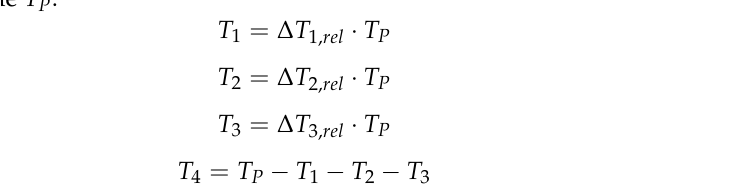
Figure 9. Sinusoidal trajectory for the four strokes with the parameters x peak = 0.03 m and ω = 80 rad depending on